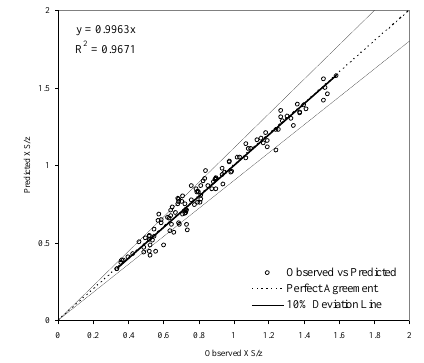
Figure 4. Comparison between observed and predicted equation (12) to estimate XS/z .